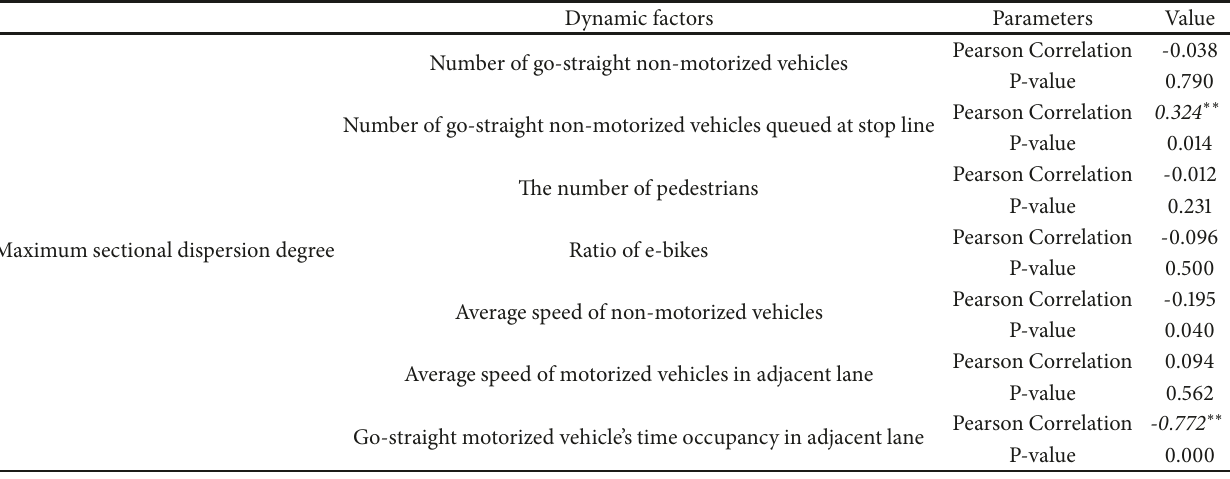
Table 2: Results of the correlation analysis in between of the maximum sectional dispersion degree and 7 dynamic factors.